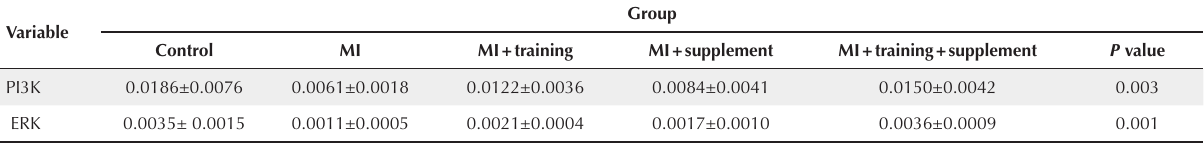
Table 2 . One-way ANOVA for PI3k and ERK Variable